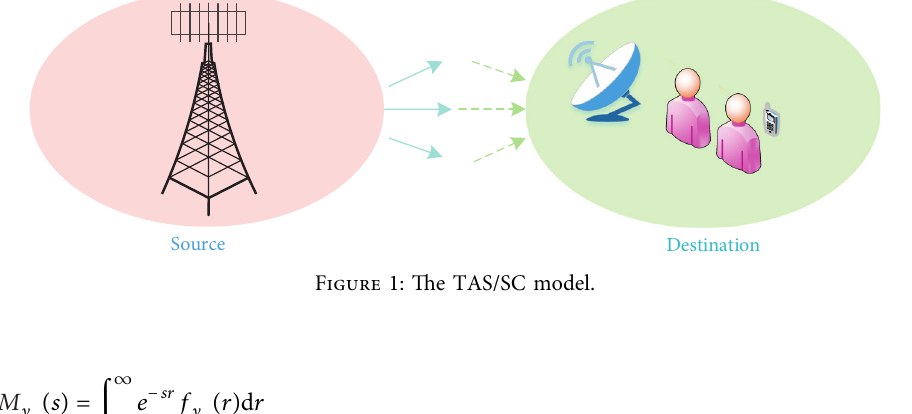
Figure 1: The TAS/SC